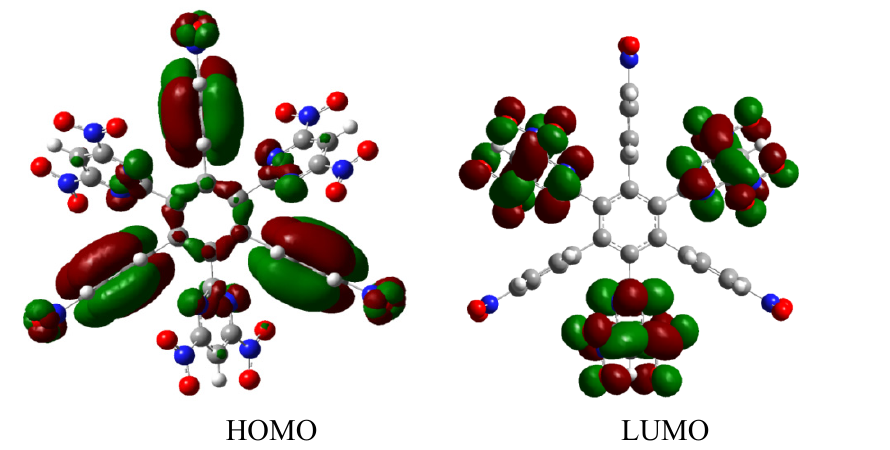
Figure 5. Frontier molecular orbitals for HAB2 .